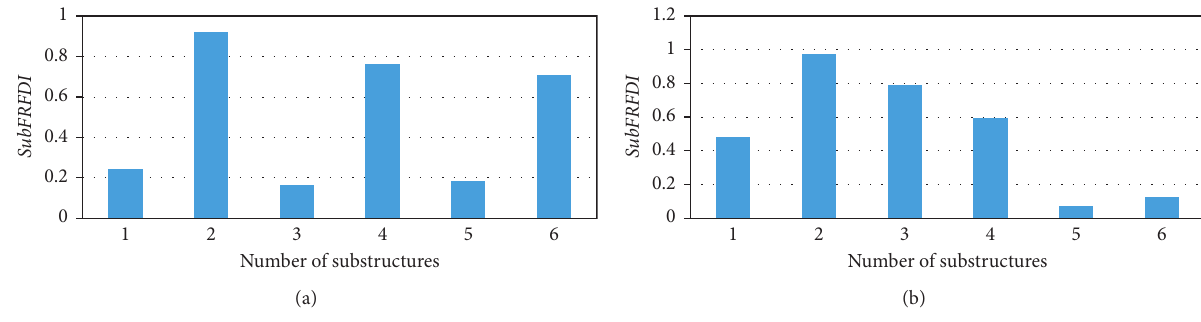
Figure 9: SubFRFDI values for (a) case Dam_2F&4F&6F15% and (b) case Dam_2F&3F&4F15%.